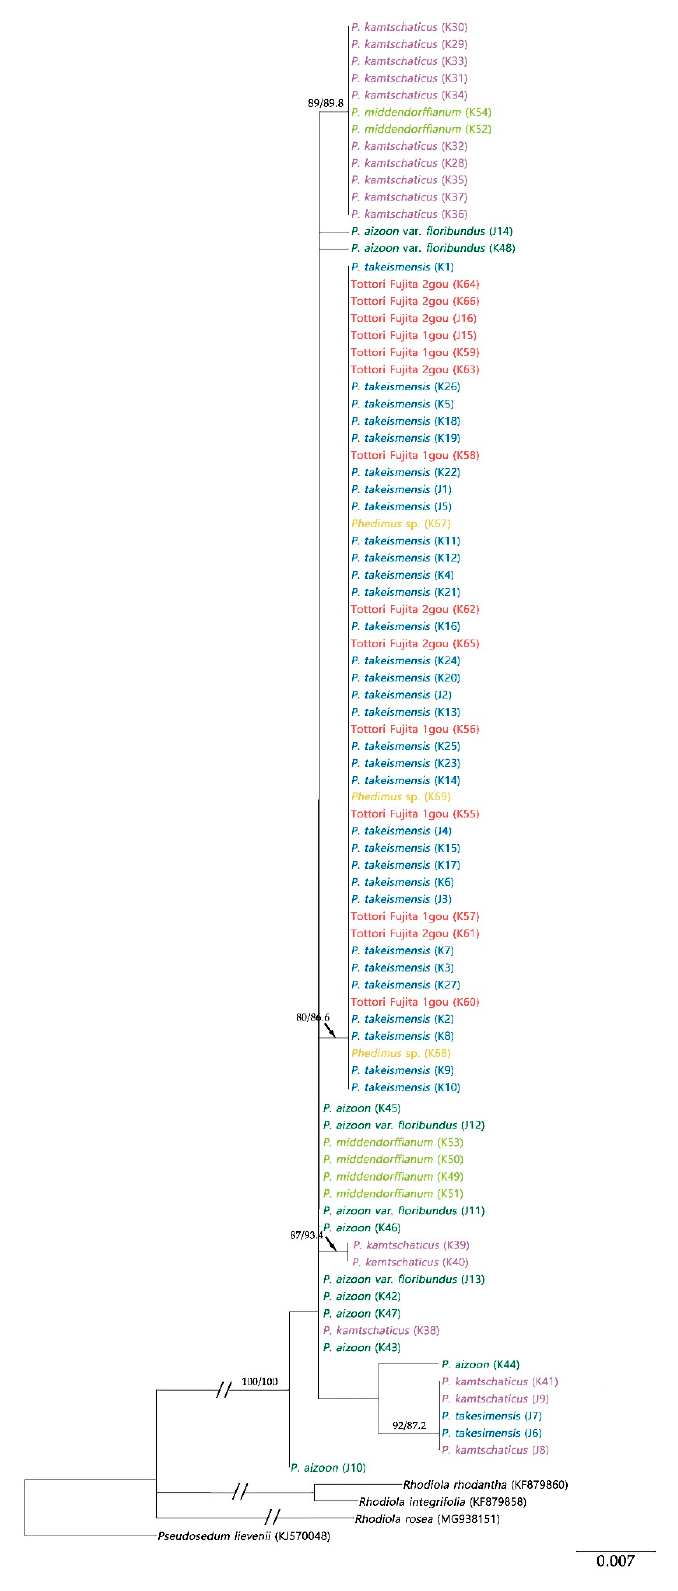
Figure 5. ML tree of the genus Phedimus using psb A- trn H sequence after correcting for the inversion. Numbers on branches indicate the bootstrap values and SH-aLRT support.